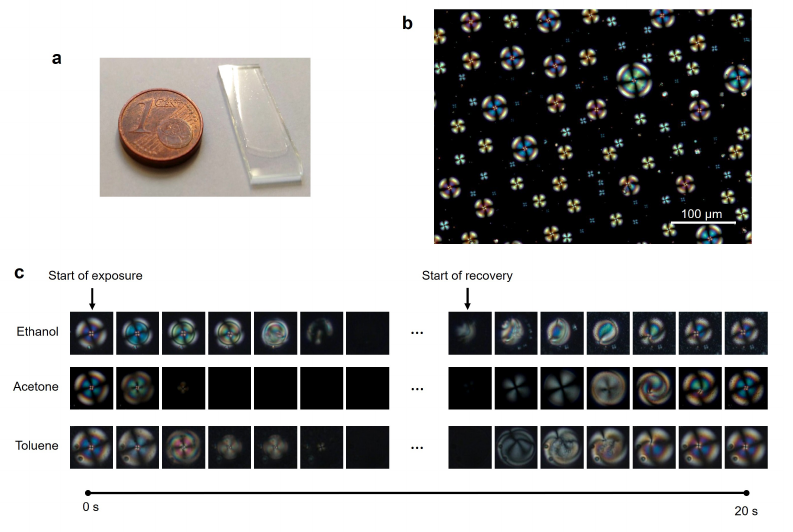
Figure 1. Macroscopic and microscopic appearance of the hybrid gel. ( a ) Hybrid gel spread as a thin film over a glass slide. ( b ) Polarising optical microscopy image, taken with crossed polarisers, of a hybrid gel region before VOC exposure. ( c ) Evolution of the optical texture of LC droplets during an exposure/recovery cycle with ethanol, acetone or acetone